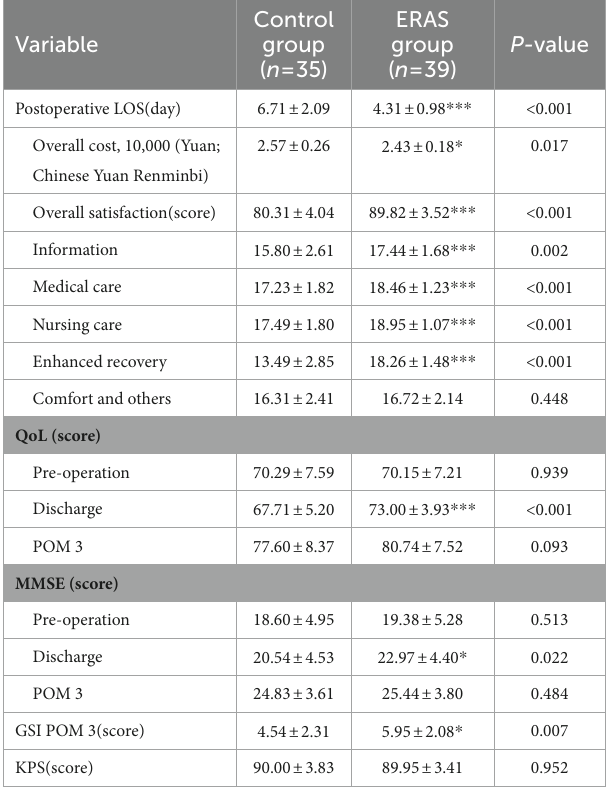
TABLE 3 Laboratory characteristics [Mean + SD]. TABLE 4 Postoperative recovery [Mean +